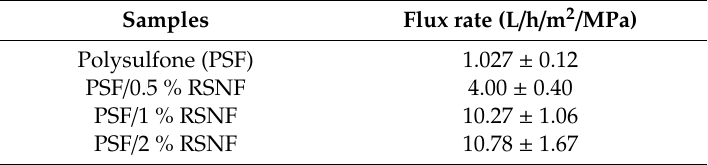
Table 5. Flux of lime nanoparticles suspension through the di ff erent membranes after 2